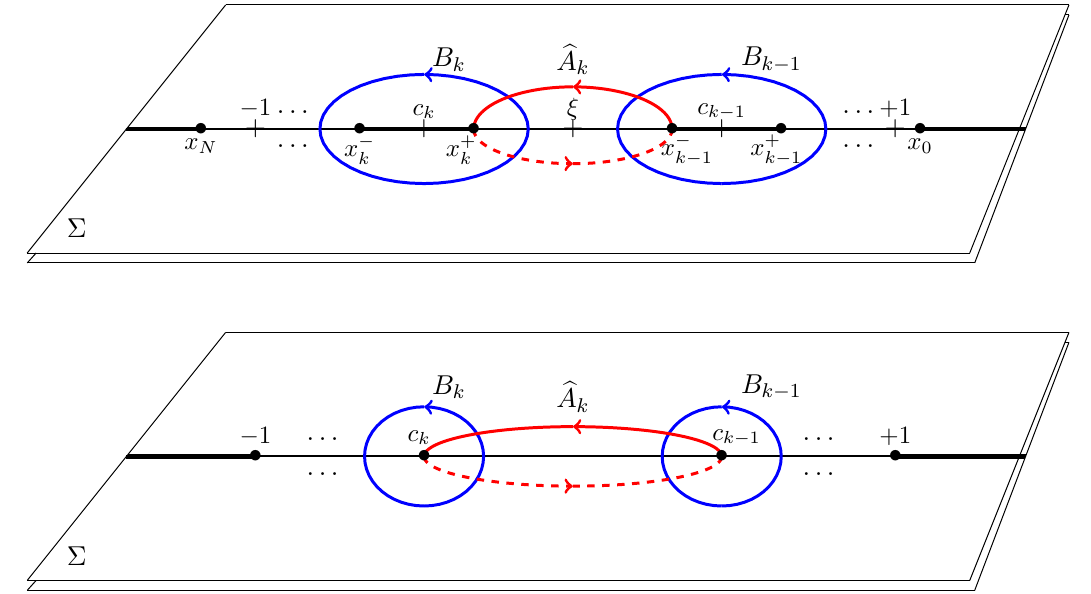
Figure 1 . The figure in the lower panel represents the singular hyperelliptic Seiberg-Witten curve at the multi-monopole point, with branch cuts ( −∞ , − 1) ∪ (+1 , + ∞ ) , singular points c 1 , . . . , c N − 1 (where the two Riemann sheets touch), and a choice of homology basis. The figure in the upper panel represents the regular hyperelliptic Seiberg-Witten curve away from the multi-monopole points, with branch cuts ( −∞ , x ) ∪ ( x − ) ∪ · · · ∪ ( x − ) ∪ ( x ) , and a choice of homology , x + , x + N 0 , ∞ 1 1 N − 1 N − 1 basis that degenerates to the homology basis of the singular curve in the lower figure. Each branch cut ( x − ) of the regular curve degenerates to the corresponding singular point c of the multi- , x + k k k monopole curve. For later use in subsection 3.2, an arbitrary point ξ ∈ ( x + ) that is well , x − k k − 1 separated from the endpoints of the interval has also been